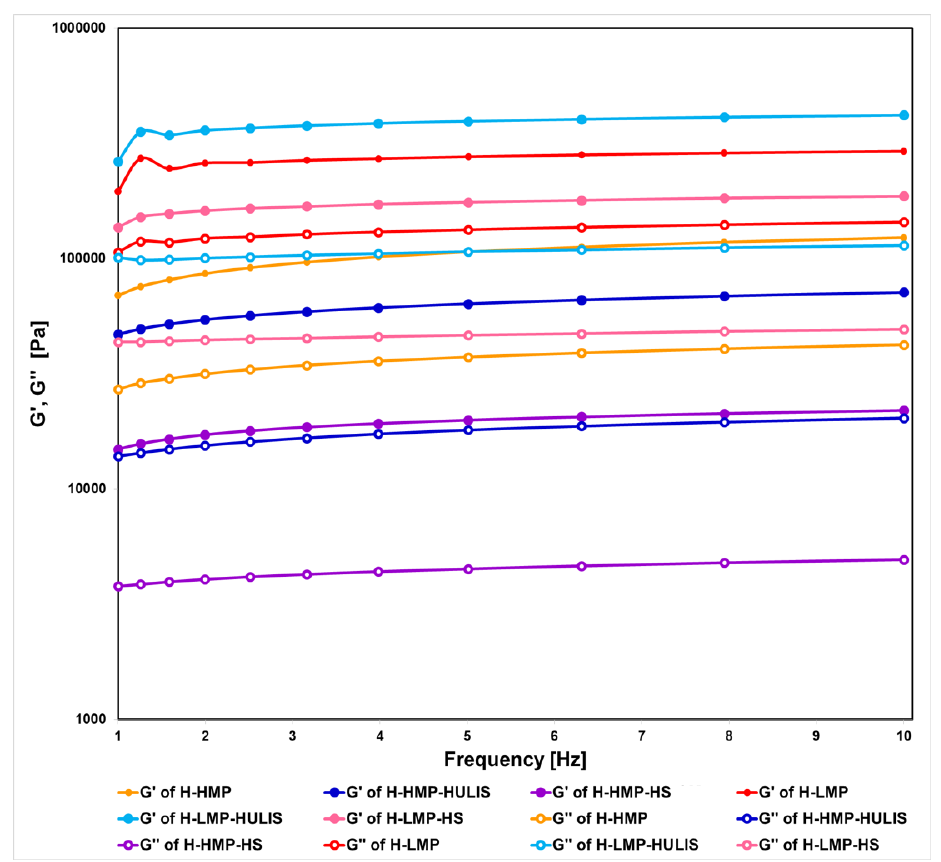
Figure 5. Storage G (cid:48) (full circles) and loss G” (empty circles) moduli as a function of applied Figure 5. Storage G’ (full circles) and loss G’’ (empty circles) moduli as a function of applied frequency.